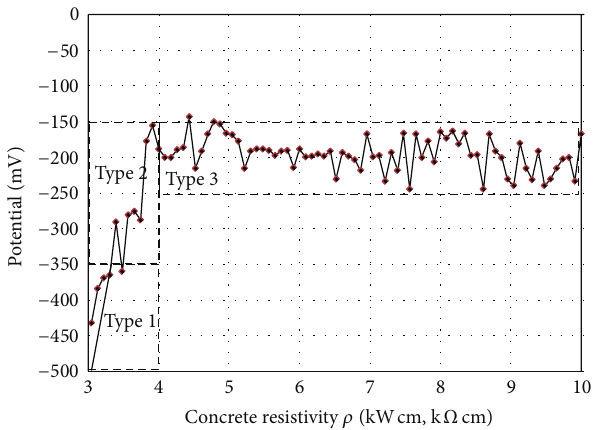
Figure 9: Concrete resistivity 𝜌 versus potential 𝐸